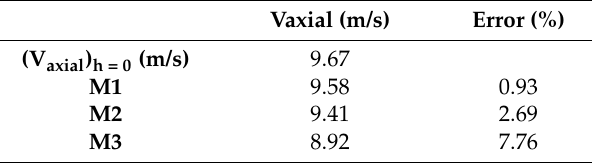
Table 7. Errors obtained for each mesh level.